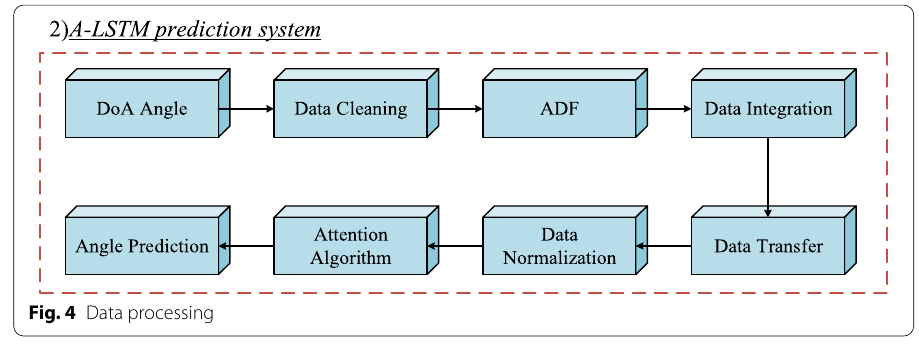
Fig. 4 Data processing